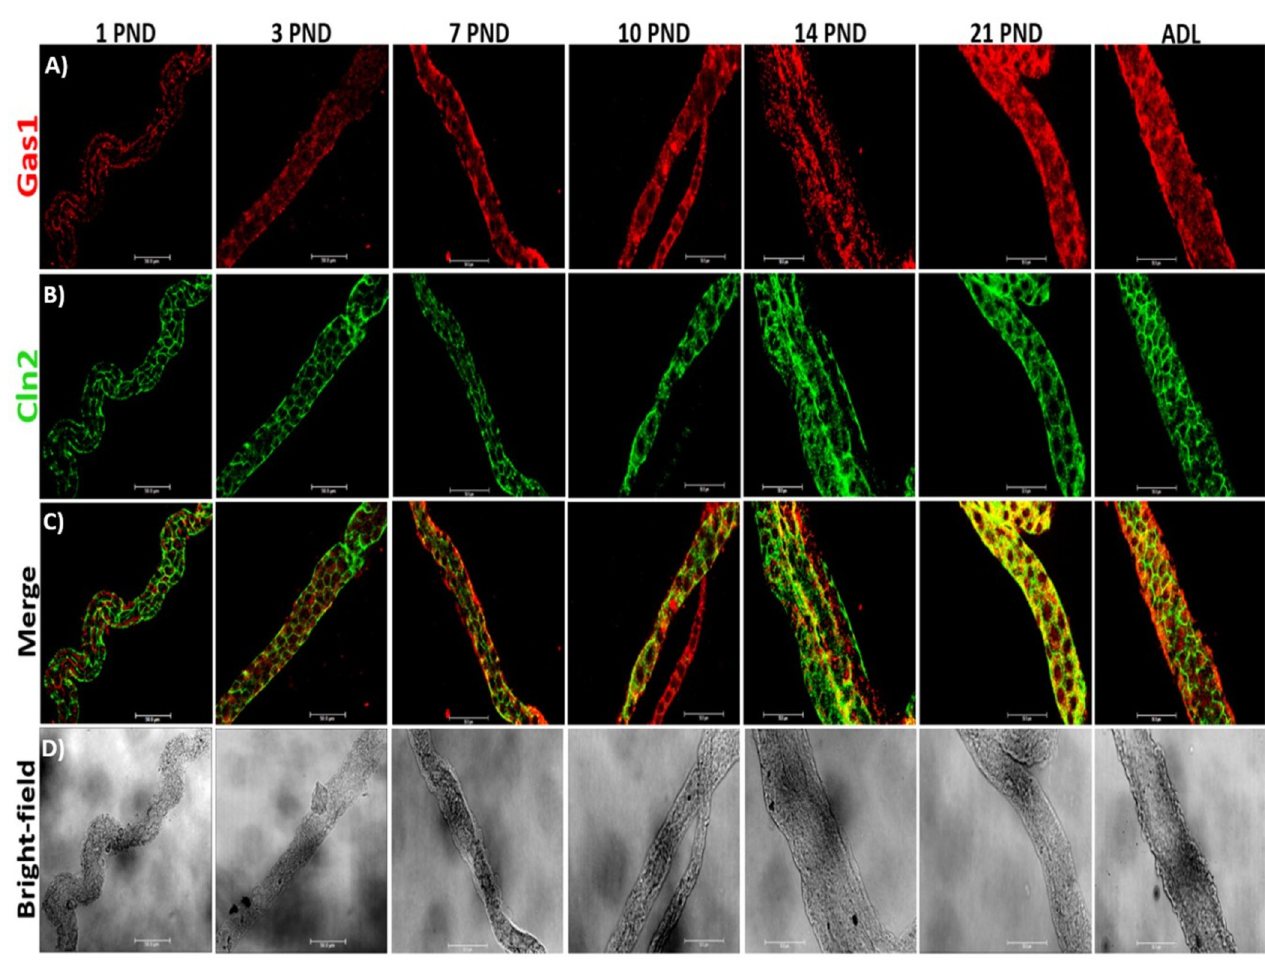
Fig 4. Gas1 is expressed in the proximal convoluted tubule in the kidney during postnatal development and in adulthood of the rat. A) immunofluorescence analysis of the general expression pattern of Gas1 in proximal tubules isolated from the renal cortex at different postnatal ages (PND) studied. We found that Gas1 is expressed cytoplasmically and increases as the kidney matures. B) Claudin protein 2 (Cln2) as a specific marker of the proximal region of the nephron. C) Merge of the Gas1 and Cln2 proteins, it can be observed that Gas1 co-localizes with Cln2 mainly at PNDs 14 and 21. D) bright-field, the classic proximal tubular contoured morphology is observed. In PND 14 and 21 there is more than one proximal tubule. In PND 10 there is a proximal tubule (Cln2+) and another tubule that is not proximal (Cln2-). Gas1 (red) and Cln2 (green) are shown. Scale bars = 50 μ m. Immunofluorescence experiments were performed in isolated renal tubules. A representative experiment is shown (n =